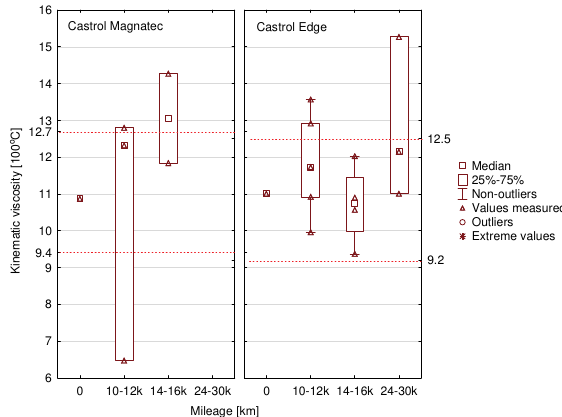
Fig. 2. Kinematic viscosity at 100°C of the engine oils